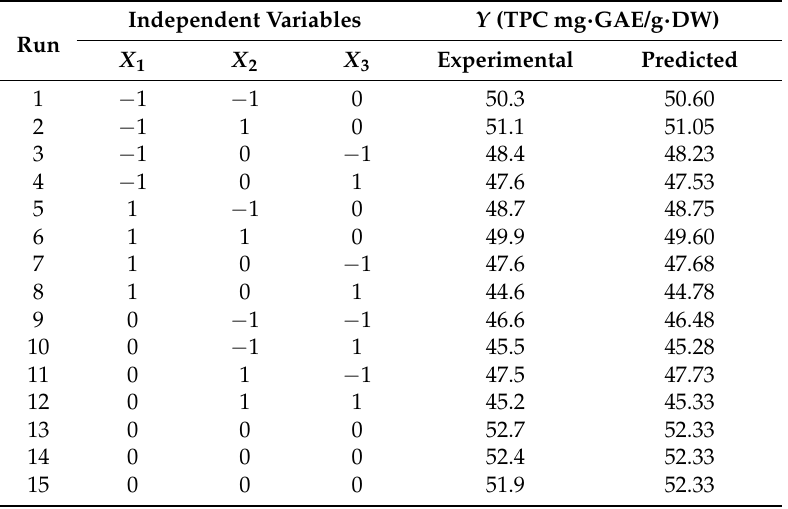
Table 1. Box-Behnken design with independent variables and its experimental response values. Independent Run